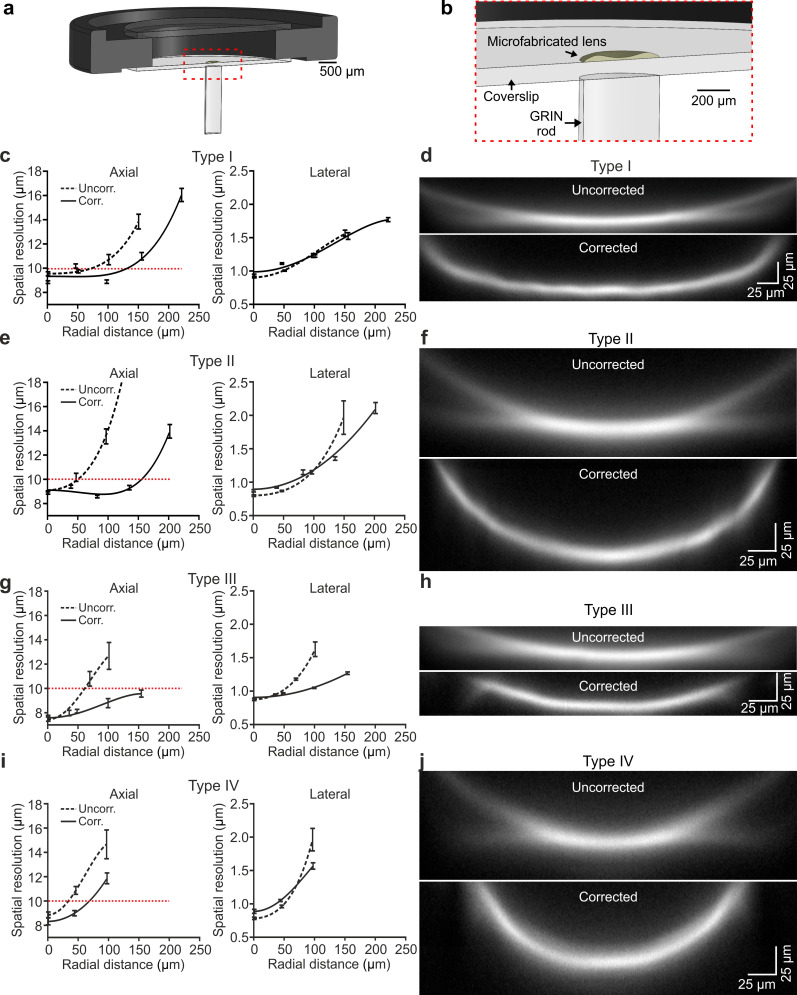
Optical characterization shows enlarged effective FOV in corrected ultrathin microendoscopes.(a) Schematic of the eFOV-microendoscope mount for head implant. The GRIN rod is glued to one side of the glass coverslip, the microfabricated polymer lens to the other side of the coverslip. The coverslip is glued on a circular metal ring that facilitates fixation on the animal's skull. (b) Zoom in of the portion highlighted with the red dotted line in (a). (c) Axial (left) and lateral (right) spatial resolution (see Materials and methods for definition) evaluated using subresolved fluorescent beads (diameter: 100 nm) as a function of the radial distance from the center of the FOV for type I uncorrected (dashed line) and corrected (solid line) microendoscopes. Points represent values obtained by averaging at least eight measurements from three different probes (see Supplementary file 1 - Table 1), while error bar represents standard deviation (sd). Lines are quartic functions fitting the data. The red dashed line indicates a threshold value (10 µm) to define the limit of the effective FOV. (d) x,z projections (x, horizontal direction; z, vertical direction) of a z-stack of two-photon laser-scanning images of a subresolved fluorescent layer (thickness: 300 nm) obtained using a type I eFOV-microendoscope, without (uncorrected, top) and with (corrected, bottom) the microfabricated corrective lens. λexc = 920 nm. (e,f) Same as in (c,d) for type II eFOV-microendoscopes. (g,h) Same as in (c,d) for type III eFOV-microendoscopes. (i,j) Same as in (c,d) for type IV eFOV-microendoscopes. See also Figure 3—figure supplements 1–7 and Supplementary file 1 - Table 3.Figure 3—source data 1.Experimental values of the axial and lateral spatial resolution as a function of radial distance from the center of the FOV in uncorrected and corrected microendoscopes.